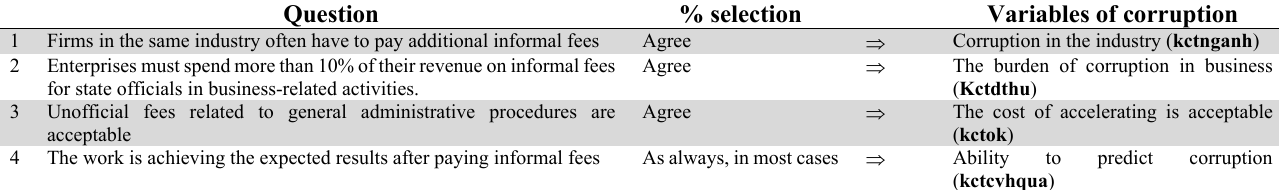
Survey questions to measure corruption variables Question % selection Variables of